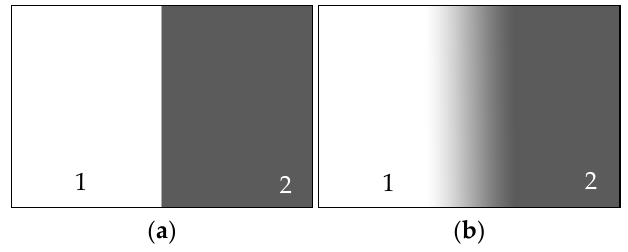
Figure 3. Class 1 and class 2 with ( a ) clear and ( b ) ambiguous borders.